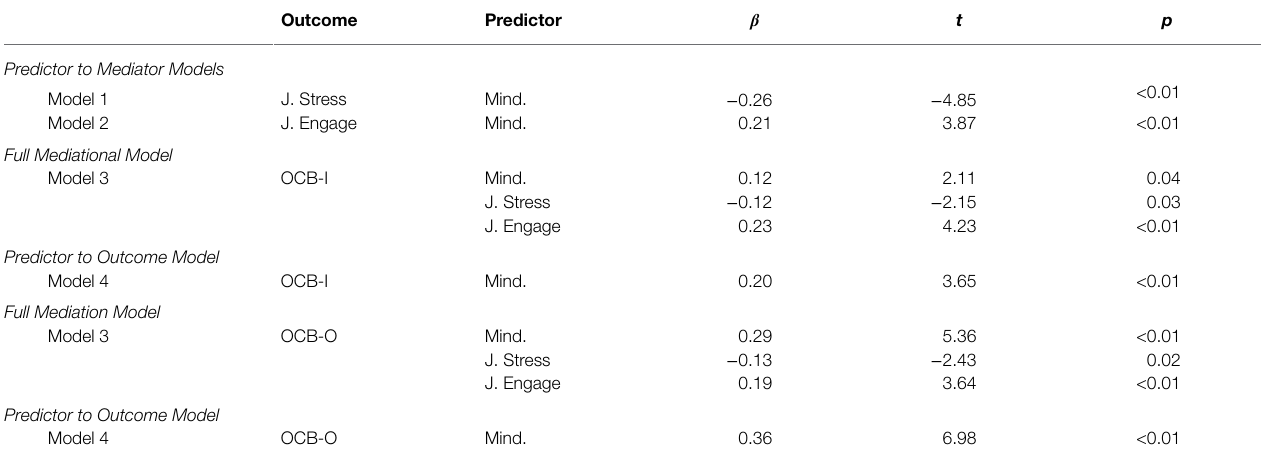
TABLE 2 | PROCESS model results for organizational citizenship-individual (top panel) and organizational citizenship-organizational (bottom panel), Study 2.